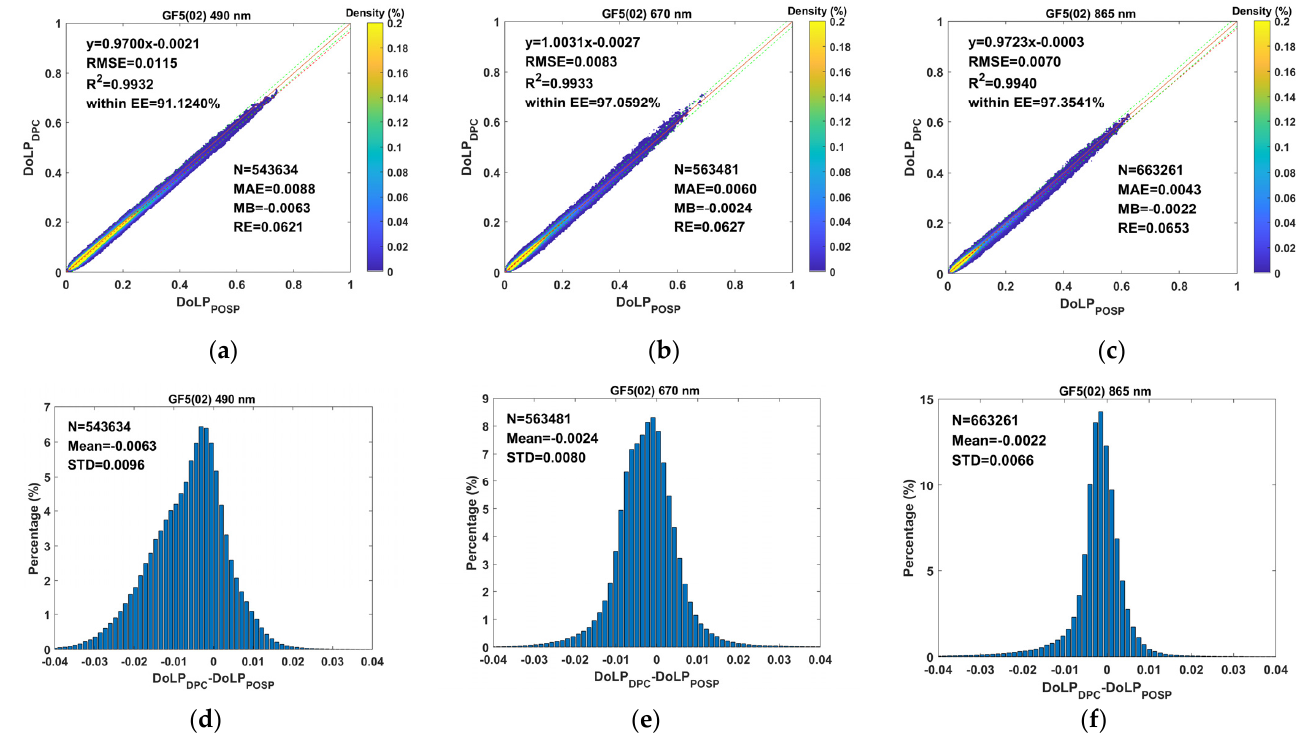
Figure 12. The linear fitting and statistical distribution results of DPC and POSP DoLP in common polarimetric bands. The data pairs are selected for collection from October 2021 to May 2022 for ( a ) and ( d ) 490 nm; ( b ) and ( e ) 670 nm; and ( c , f ) 865 nm bands in DPC and POSP Level 1 products. Yellow solid, green, and red dashed lines are the 1:1 lines, EE envelope lines, and fit lines, respec- tively.